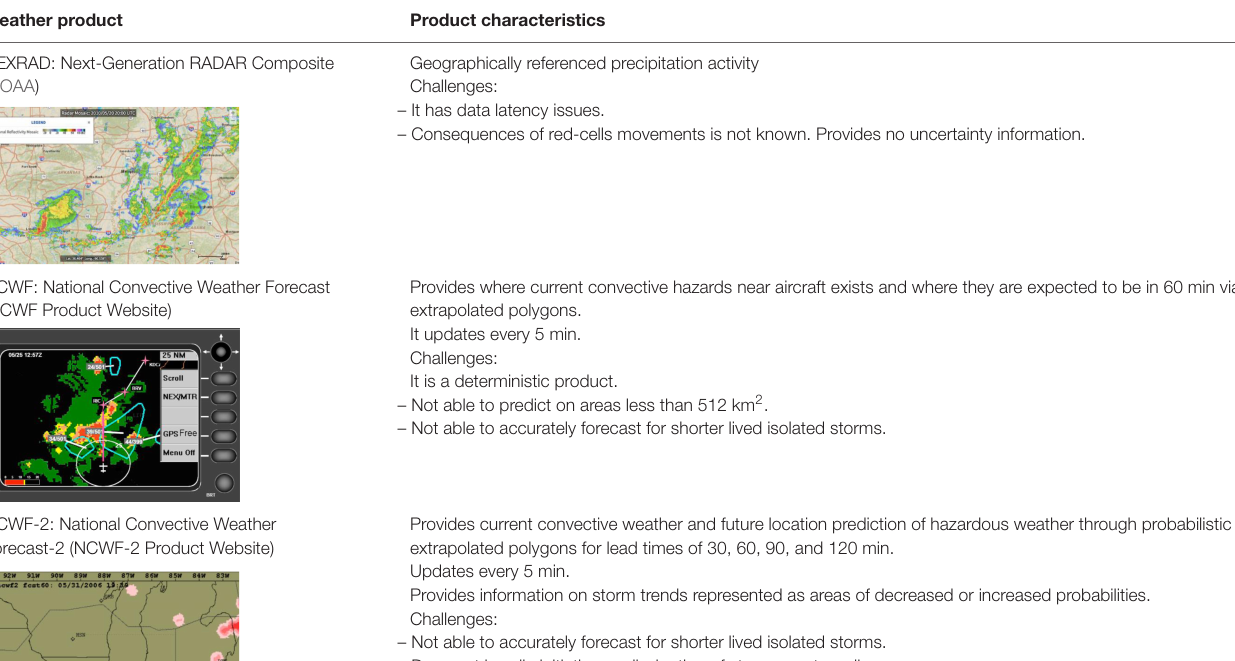
TABLE 1 | Descriptions of several meteorological aviation-weather products. Weather product Product